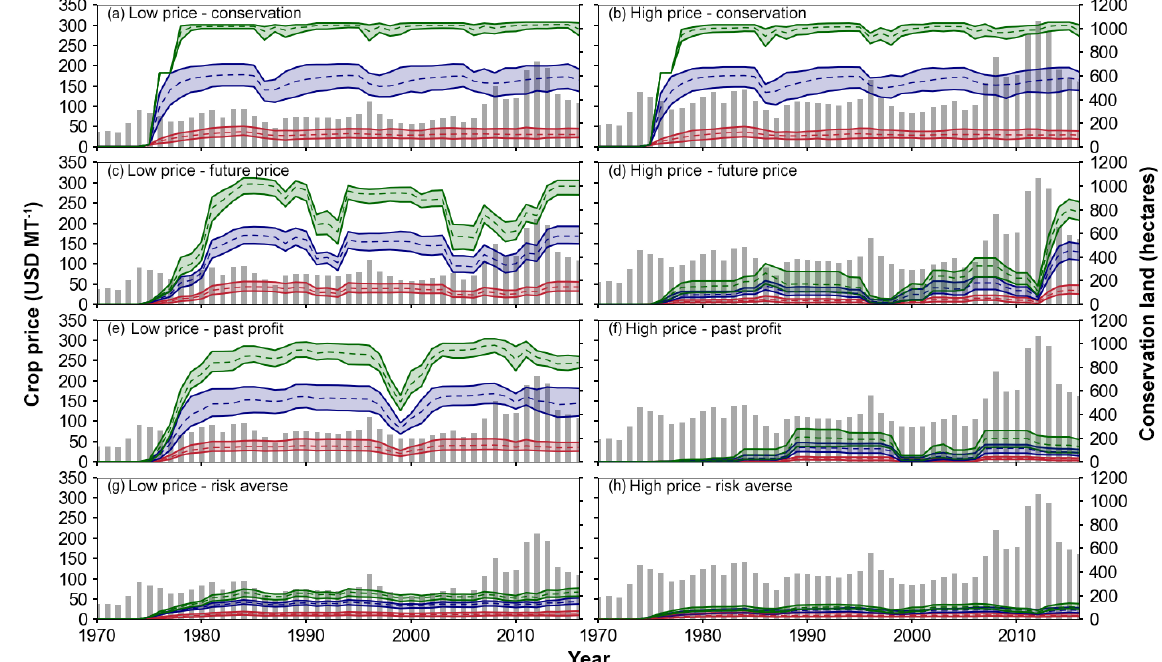
Figure 8. Range of simulated conservation land within the watershed with low (a, c, e, g) and high (b, d, f, h) crop prices for conservation- minded populations (green), mixed populations (blue), and production-minded populations (red). Crop prices are plotted as bars for each crop price scenario. Results are for decision schemes of 80% weight on conservation behavior (a, b) , 80% weight on future price (c, d) , 80% weight on past profit (e, f) , and 80% weight on risk aversion (g, h)